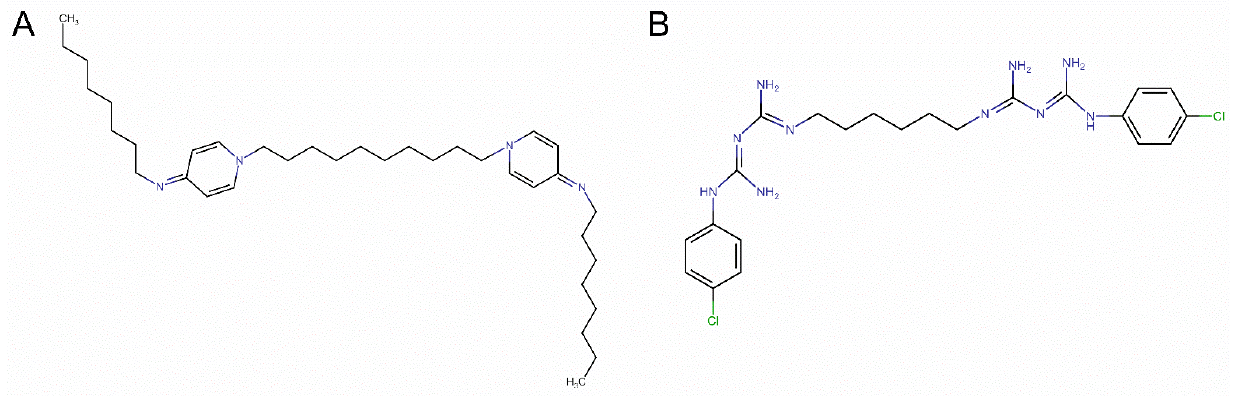
Figure 1. The chemical structures of antibacterial agents ( A ) OCT and ( B )